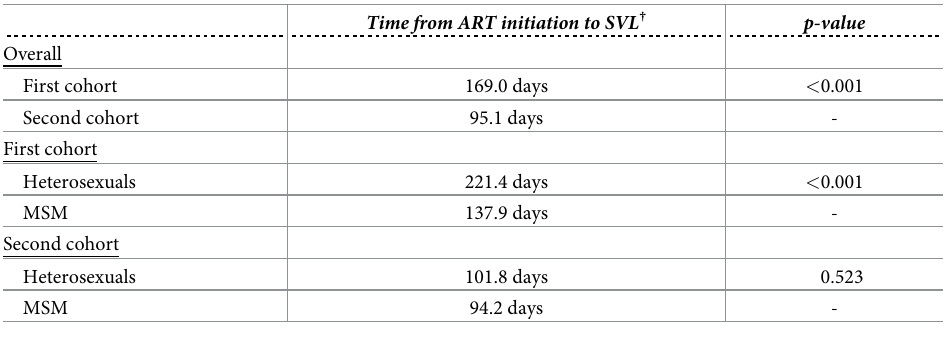
Table 3. Analysis of number of days from antiretroviral therapy initiation to achieving suppressed viral load by cohort and route of